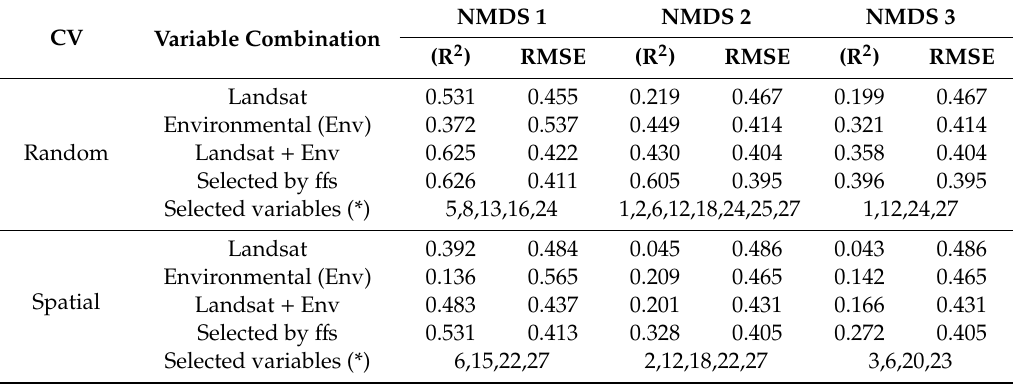
Table 2. Statistical performance of the random forest models for predicting floristic ordination axes (NMDS 1–3 shown in Figure 2b,e,h). Models were compared by the type of cross-validation (CV) and by di ff erent initial sets of predictor variables. Final sets of predictor variables were selected based on the forward feature selection ( ff s) method. Model performance was assessed through the root-mean-square-error (RMSE) and the coe ffi cient of determination (R 2 ) averaged over all folds from the corresponding cross-validation. (*) The selected variables are listed using the same numbering as